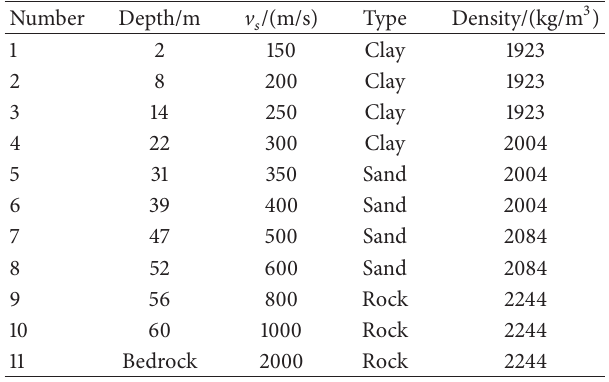
Table 1: Original soil profile